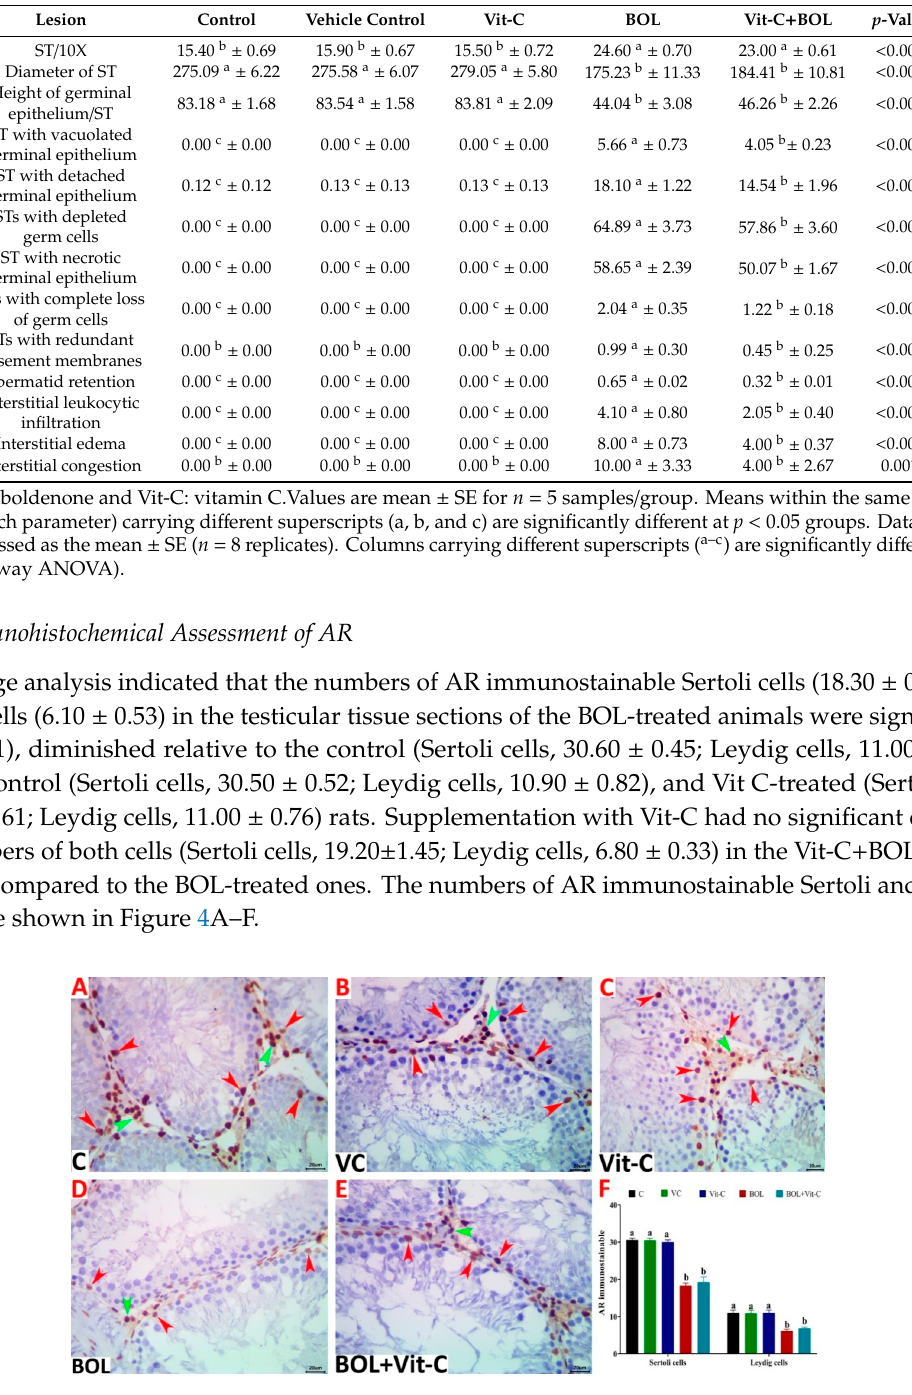
Table 3. Lesion scoring in the testicular tissues of rats in response to boldenone (5 mg / kg bwt / once a week, 8 weeks) and / or vitamin C (120 mg / kg b.wt / daily, 8 weeks) treatment.